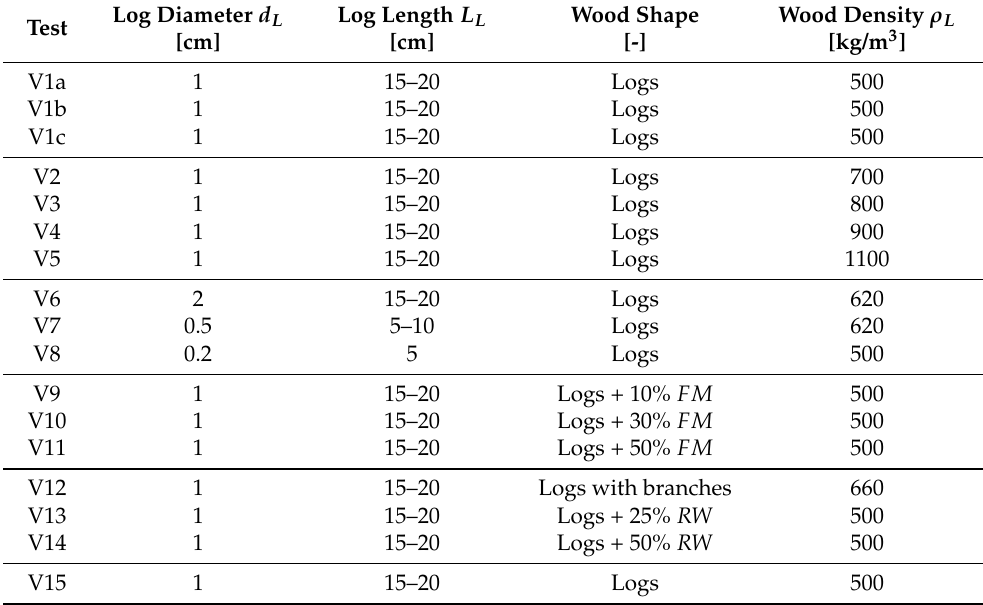
Table 1. Test program with bottom clearance height f m d 84 = 19 mm, discharge Q = 11.6 l/s,